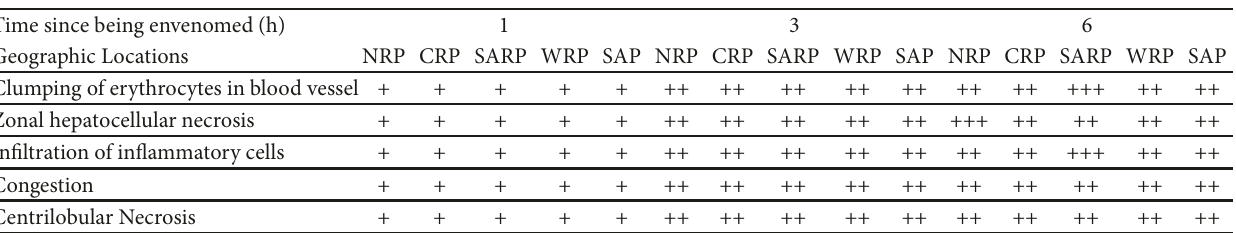
Table 5: Major histopathological changes in liver by N. naja venom from distinct geographic origins in Sri Lanka. Score: 0: absent; +: mild; ++; moderate; and +++: severe